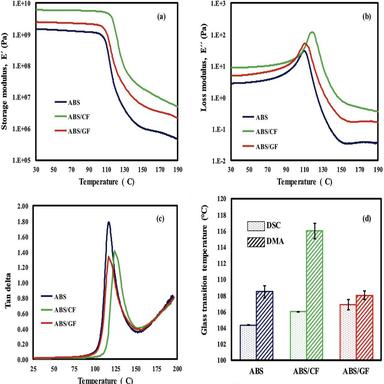
Representative DMA results for (a) storage modulus E′, (b) loss modulus E′′, (c) tanδ, and (d) comparison of measured Tg between DMA and DSC characterization (average of five measurements and errors bars represent ± one standard deviation).